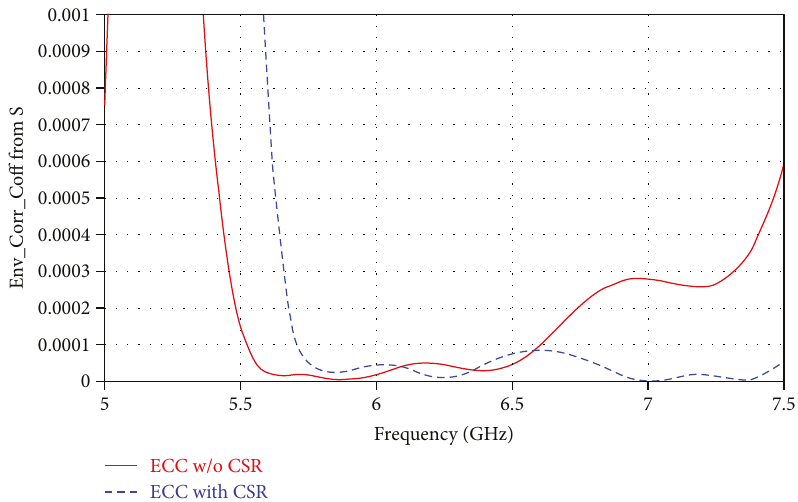
Figure 20: ECC of orthogonal MIMO system with and without MTM-CSR matrix structure.